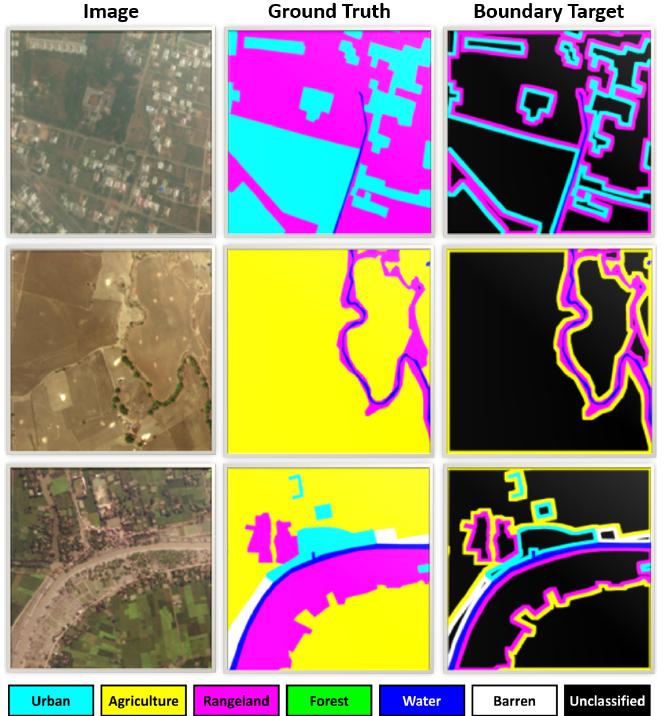
Figure 8. Images, ground truths, and boundary targets generated by the Sobel operator and dilation operation with d = 50